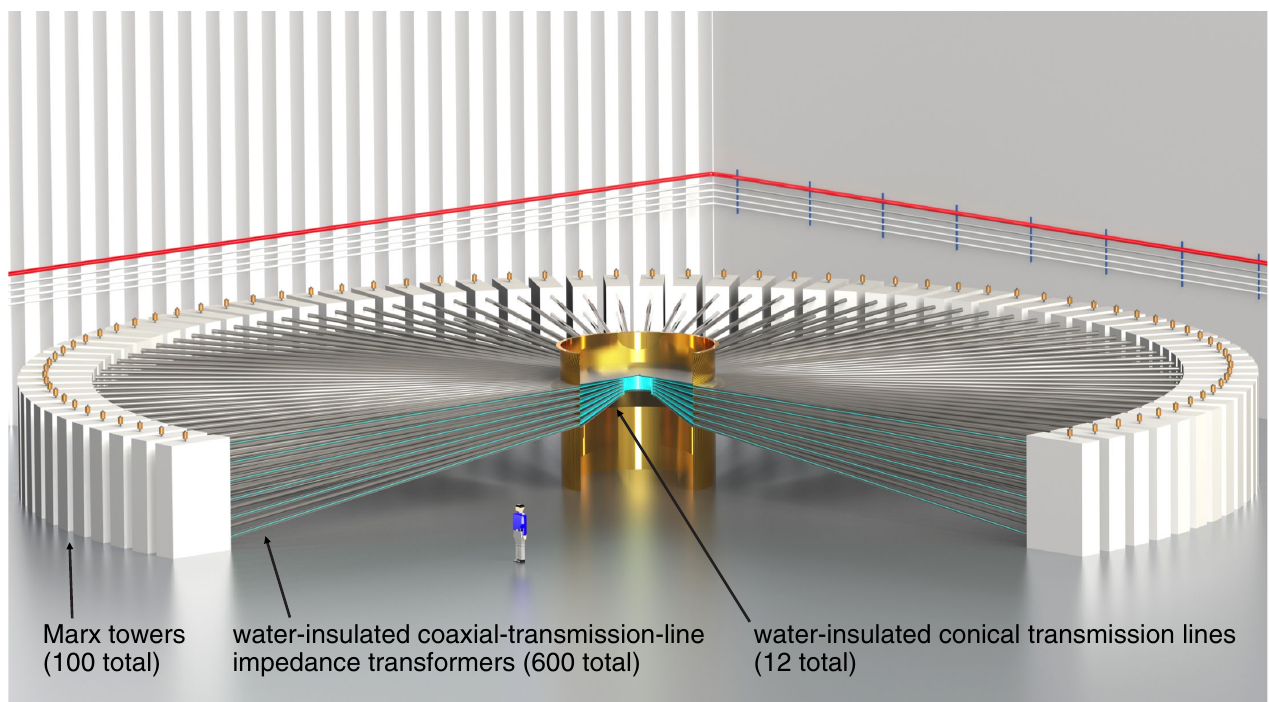
FIG. 3. Cross-sectional view of a three-dimensional model of Neptune. Each Marx tower includes six Marx